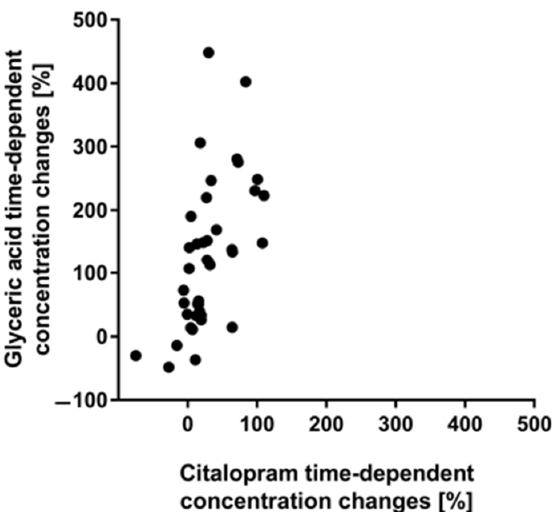
Figure 4. Graphical representation of the correlation analysis; correlation between citalopram and glyceric acid time-dependent concentration changes [%]; x- and y- axis were cut at 500% for better visualization.